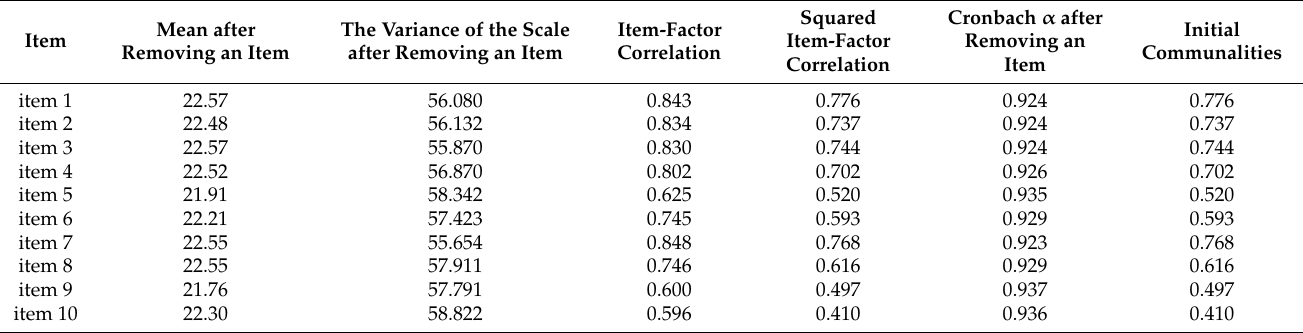
Table 3. Means, item-to-total correlations, and Cronbach’s alphas after removing specific items from the Polish